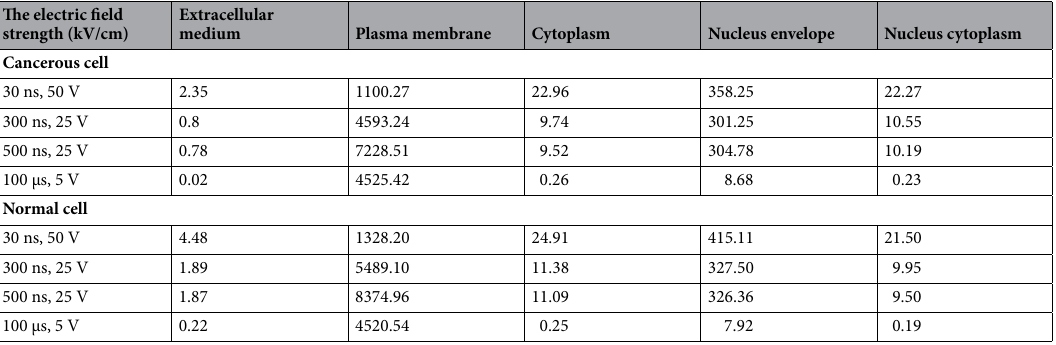
Table 2. The maximums of the electric field strength at the midpoints of each structure on the axis of two models.